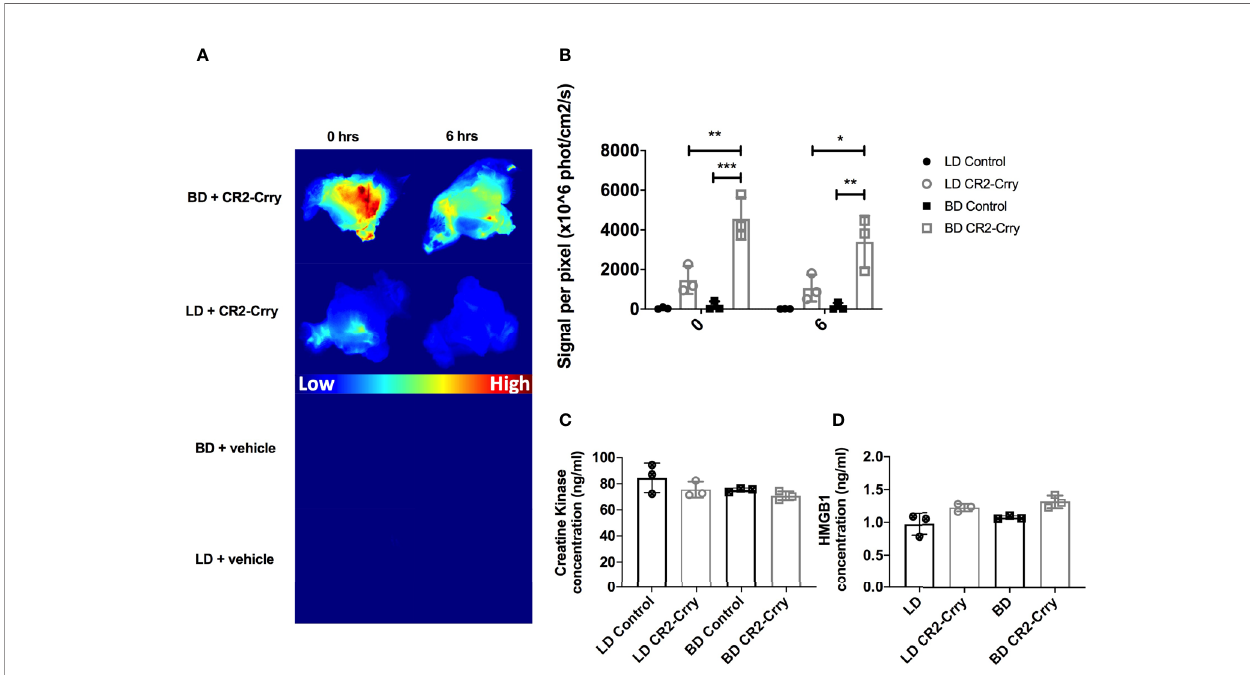
FIGURE 2 | CR2-Crry binds at a higher level in BD donor grafts compared to LD grafts and is not associated with toxicity during cold storage. LD and BD VCAs were perfused with UW or UW augmented with fl uorescently labeled CR2-Crry prior to graft harvest and grafts were imaged ex vivo . (A) Heatmaps showing fl uorescence signal intensity of images of grafts at the beginning (t = 0) and end (t = 6hrs) of cold static storage and, (B) Their respective signal intensity quanti fi cation. Pairwise comparison at t=0 between BD vs BD+CR2-Crry (***p < 0.001), LD+CR2-Crry vs BD+CR2-Crry (**p < 0.01); difference between LD vs LD+CR2-Crry was not signi fi cant. Similarly, pairwise comparison at t=6hrs between BD vs BD+CR2-Crry (**p < 0.01), LD+CR2-Crry vs BD+CR2-Crry (*p < 0.05); difference between LD vs LD+CR2-Crry was not signi fi cant. Perfusates were collected from VCAs at the end of cold storage were assayed for the concentration of tissue injury markers creatine kinase (C) and HMGB1 (D) using ELISA. For CK, Pairwise comparisons between LD vs BD, LD vs LD+CR2-Crry, and BD vs BD+CR2-Crry, and LD vs BD+CR2-Crry were not signi fi cant. The same applies for HMGB1 except for LD vs BD+CR2-Crry (*p < 0.05). (n = 3, *p < 0.05, **p < 0.01, ***p <